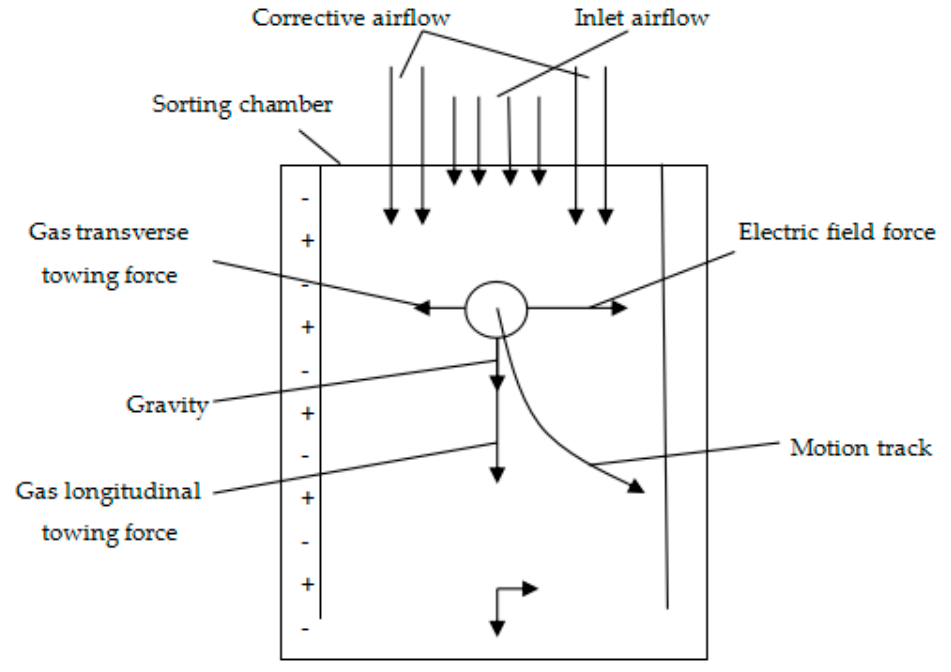
Figure 2. The trajectory of particles in an electric field.